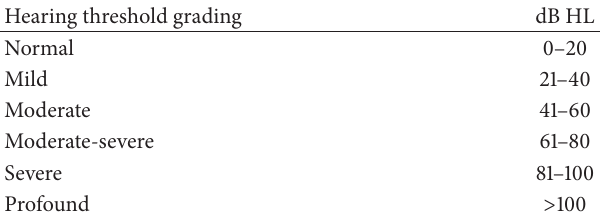
Table 1: Hearing threshold was used in our